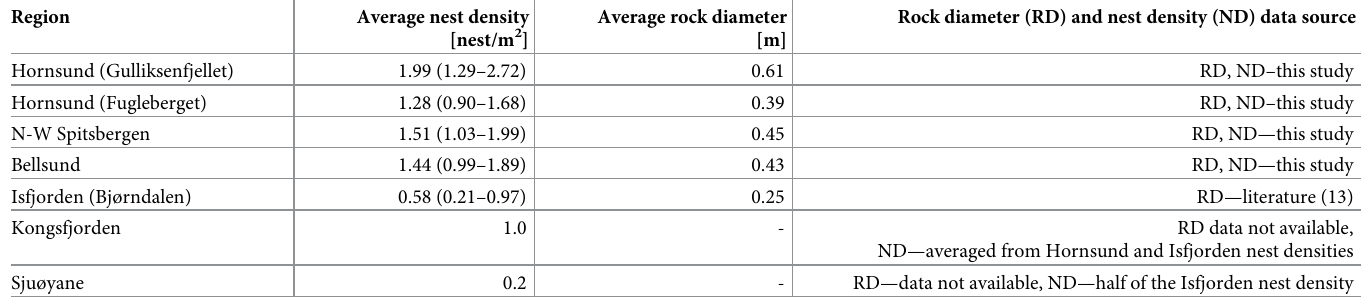
Table 2. Estimated density of nests (with 95% CrI in parentheses) and rock diameters in the surveyed little auk colonies. The density values marked as “this study” are the estimates of mean densities from the nest density model (see section “Colony patch characteristics” above and S1